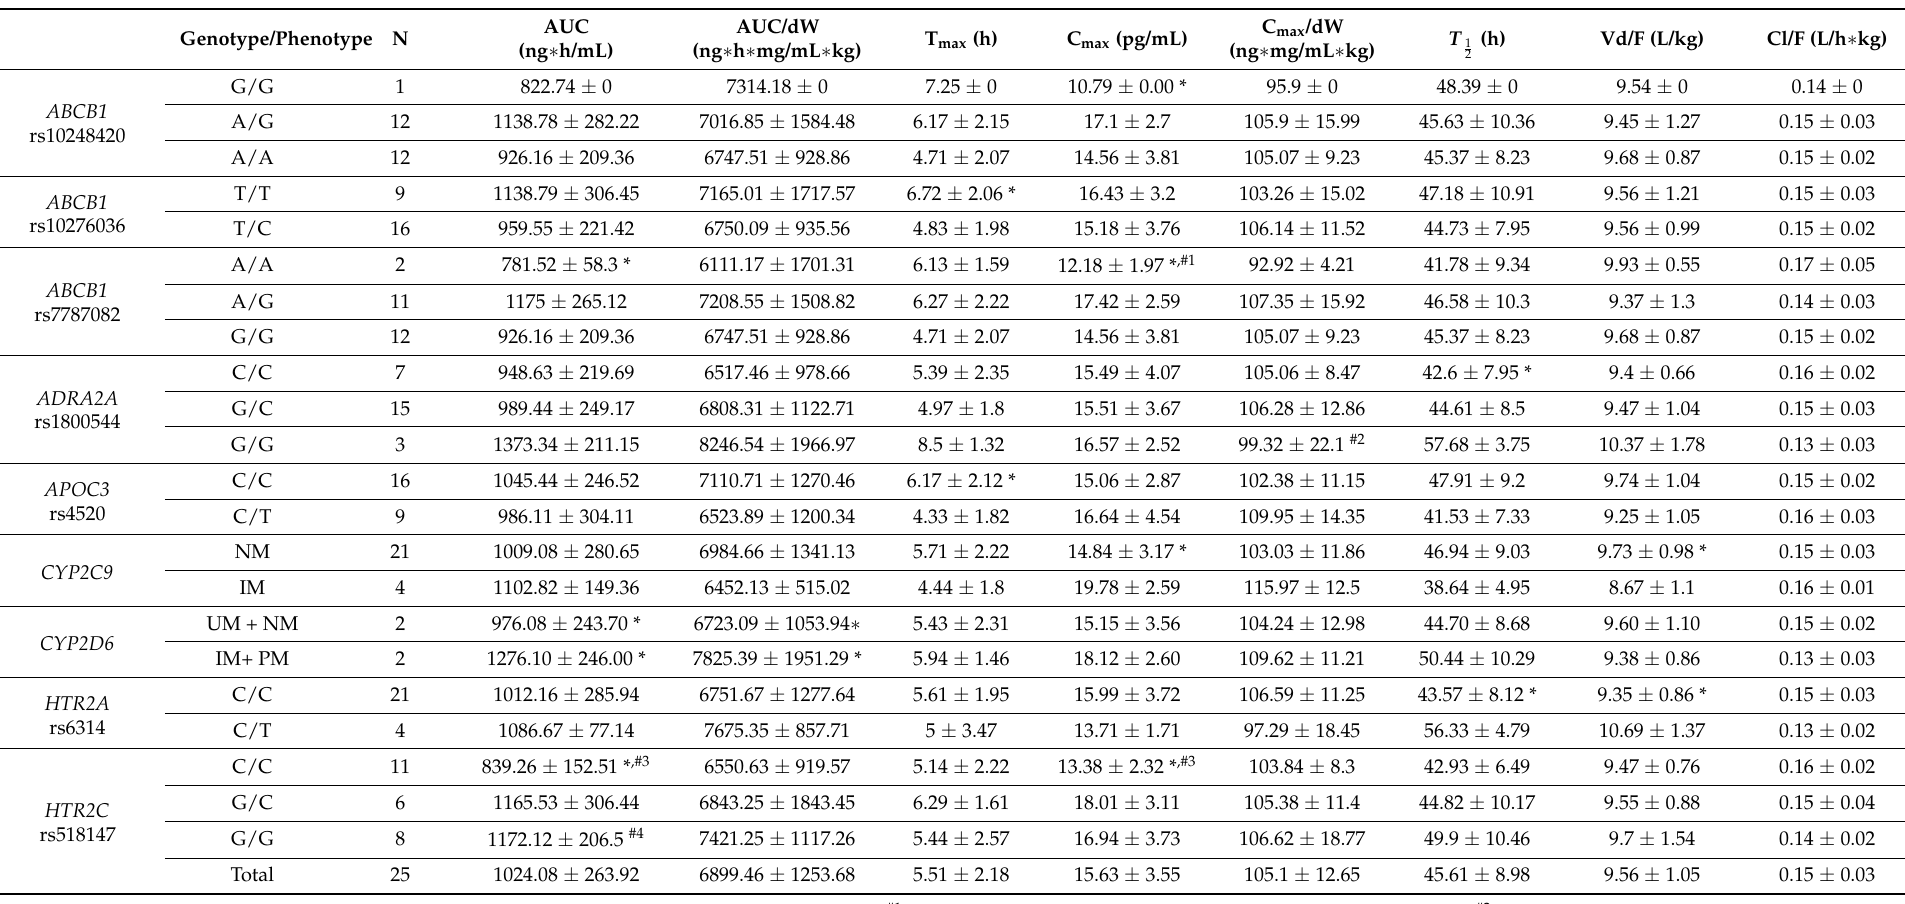
Table 3. Summary of the genotypes and phenotypes that showed a significant association with memantine’s pharmacokinetic parameters in the univariate